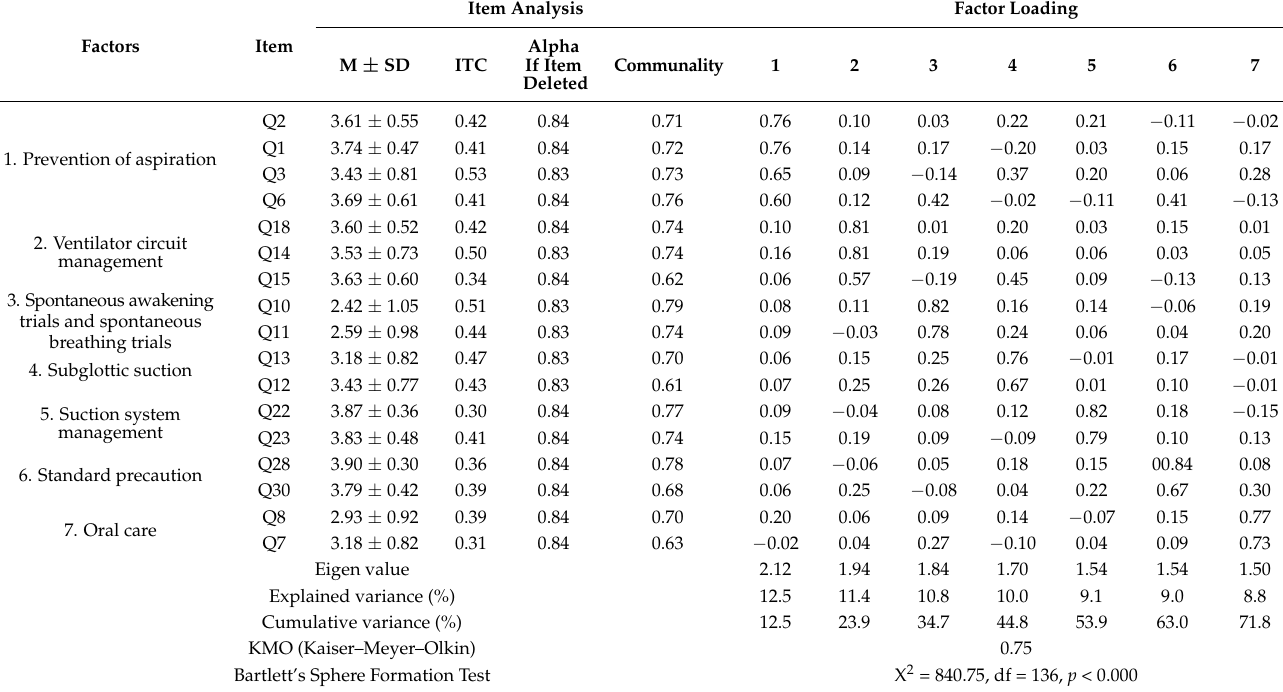
Table 2. Factor loading of items according to the factors and eigenvalue (17 Items) ( n = 180).